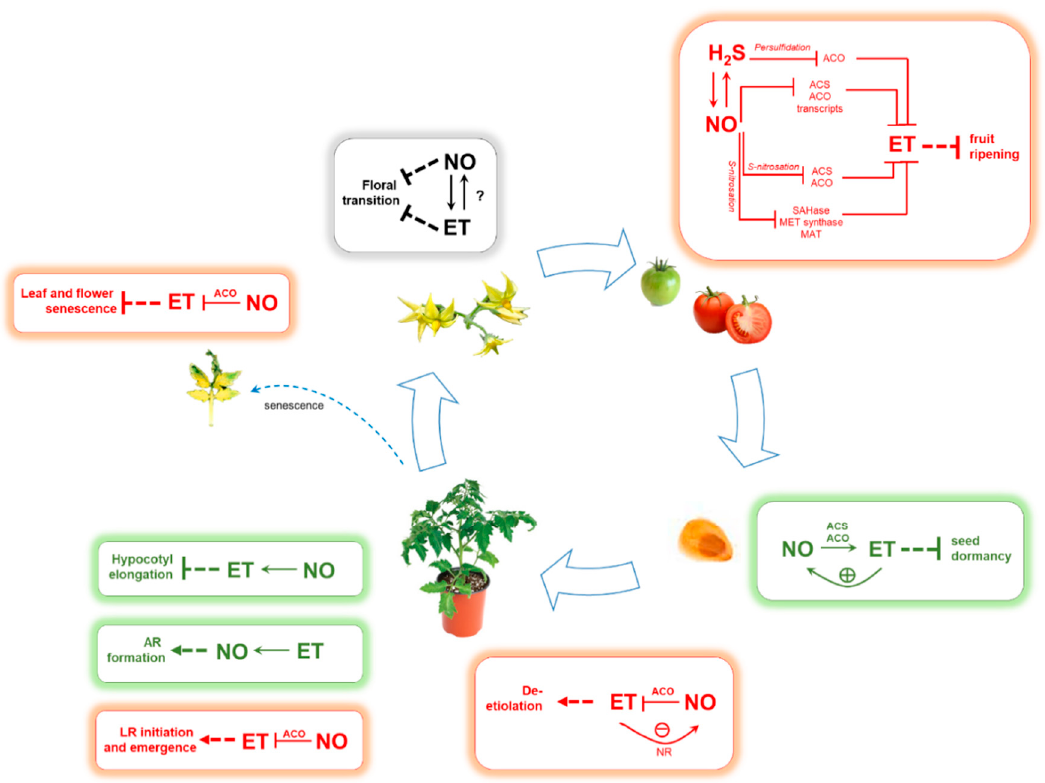
Figure 2. Nitric oxide (NO)-ethylene (ET) interactions during plant growth and development. Synergistic interplay was indicated in green, while antagonism was indicated in red. Abbreviations: ACS, 1-aminocyclopropane-1-carboxylic acid synthase, ACO, aminocyclopropane-1-carboxylic acid oxidase; SAHase, adenosyl homocysteinase; MET synthetase, methionine synthetase; MAT, methionine adenosyltransferase; LR, lateral root; AR, adventitious root.